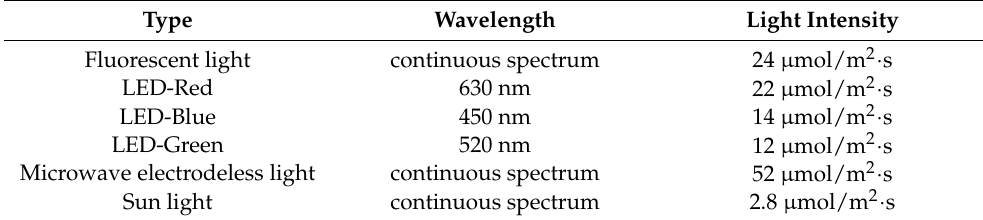
Table 3. The characteristics of artificial light sources used in the